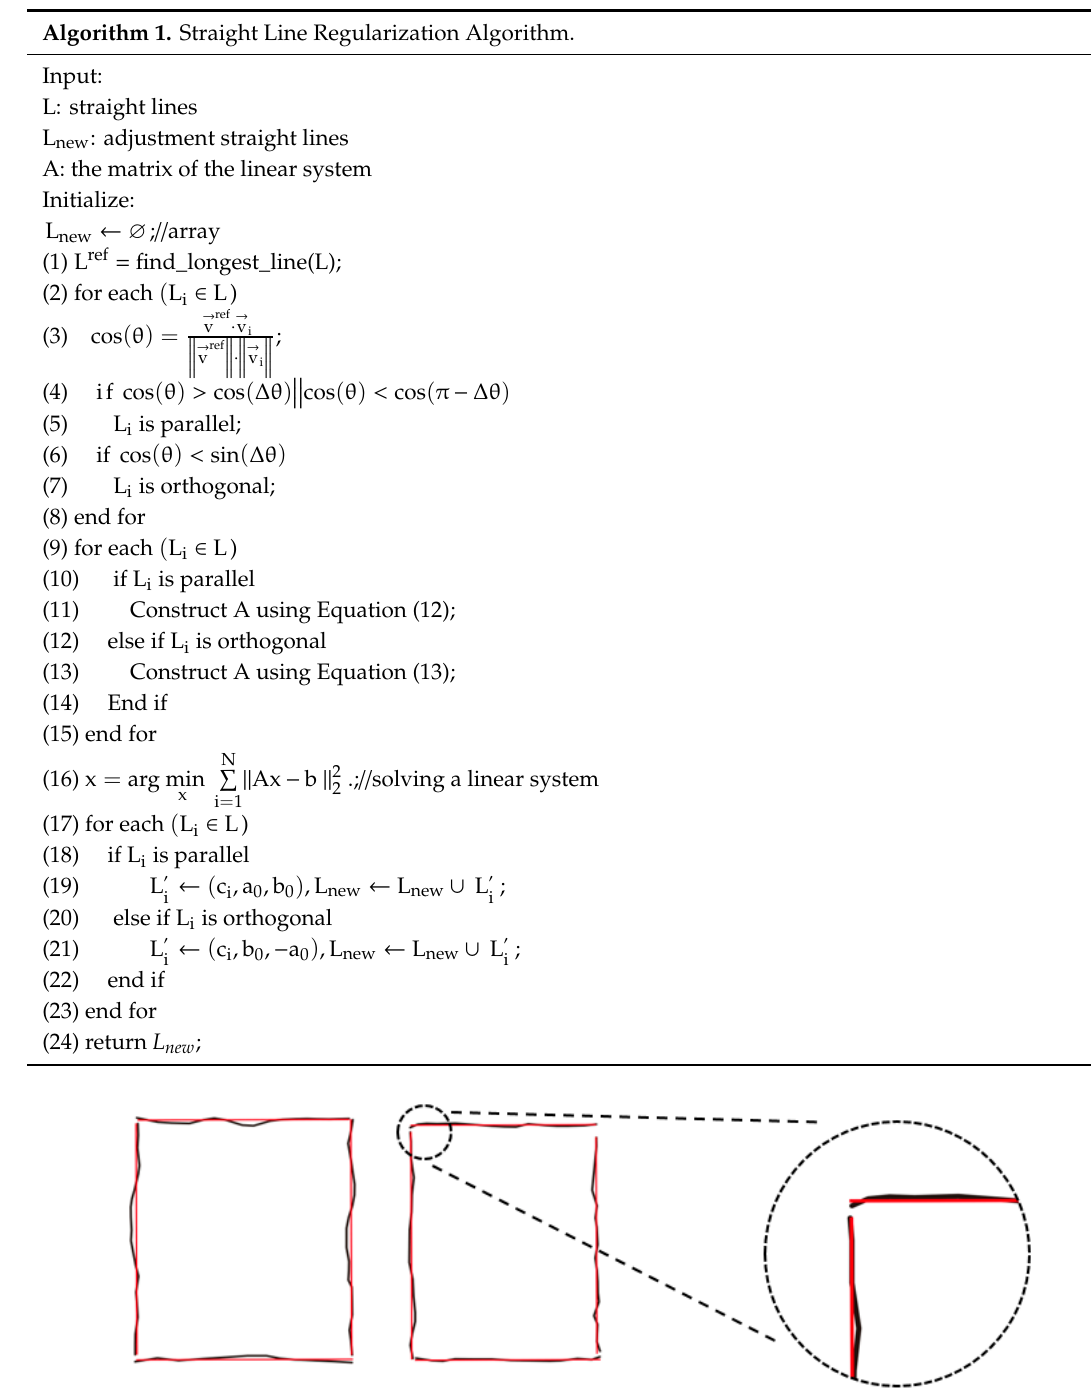
Figure 7. Examples of straight line regularization.